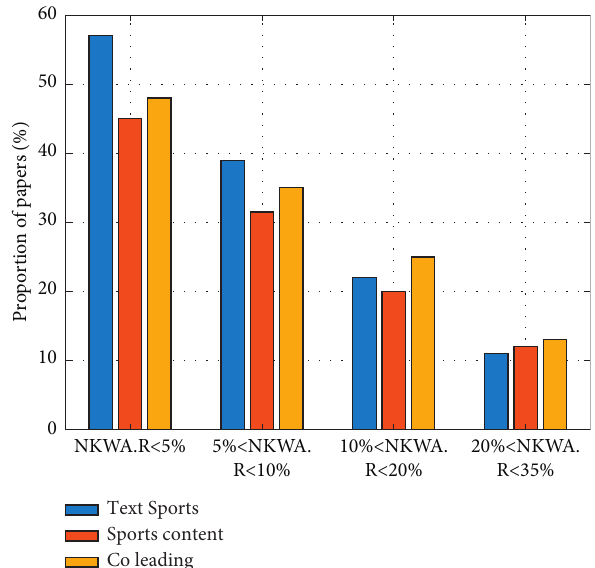
Figure 10: Percentage of each dominant type in different stages of